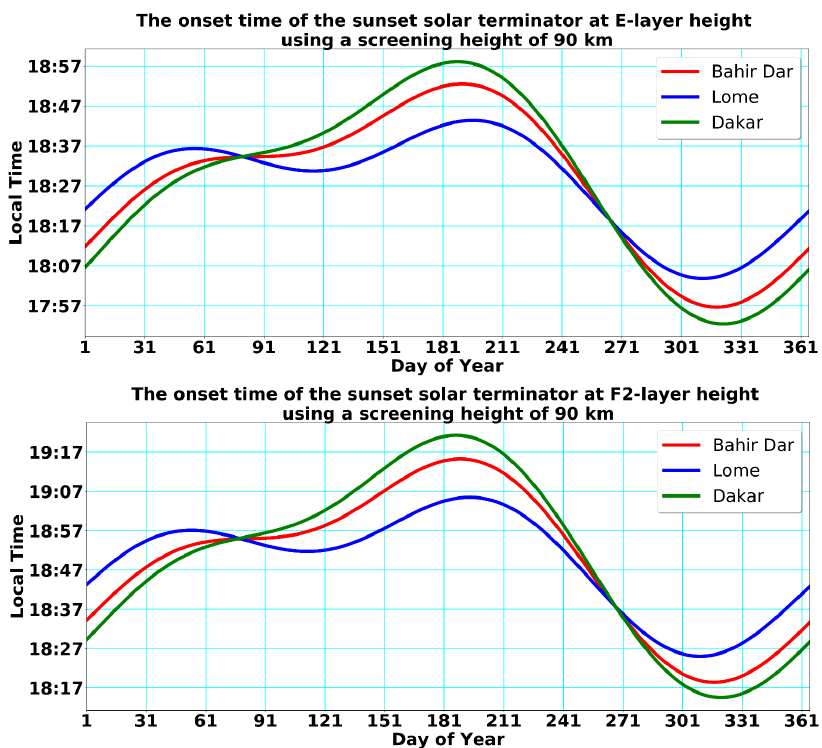
Figure 4. Time of sunset computed for Bahir Dar (red), Lomé (blue) and Dakar (green) at E-layer and F2-layer heights using a screening height of S = 90 km (( upper panel ) h I = 120 km; ( lower panel ) h I = 250